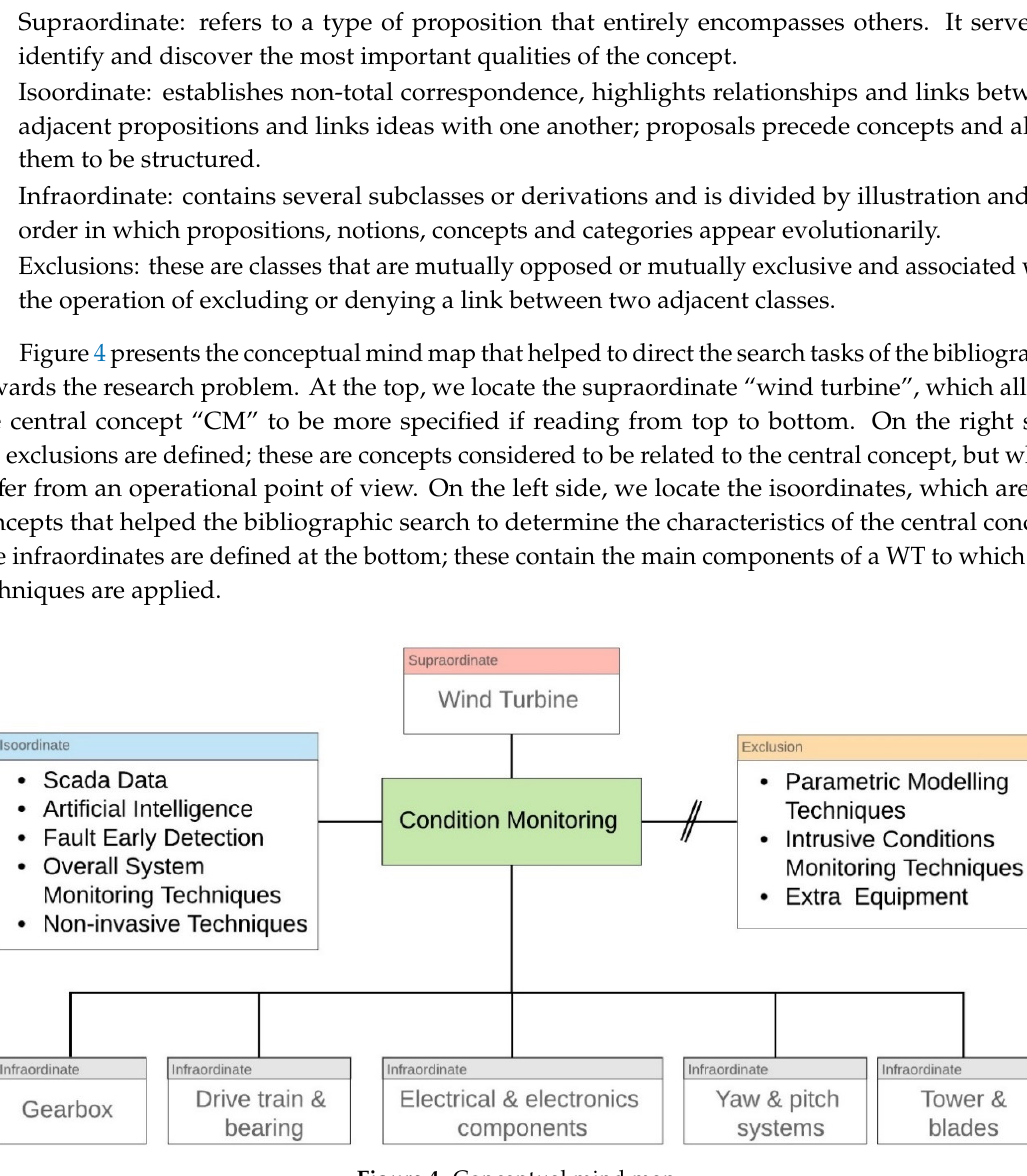
Figure 4. Conceptual mind map.